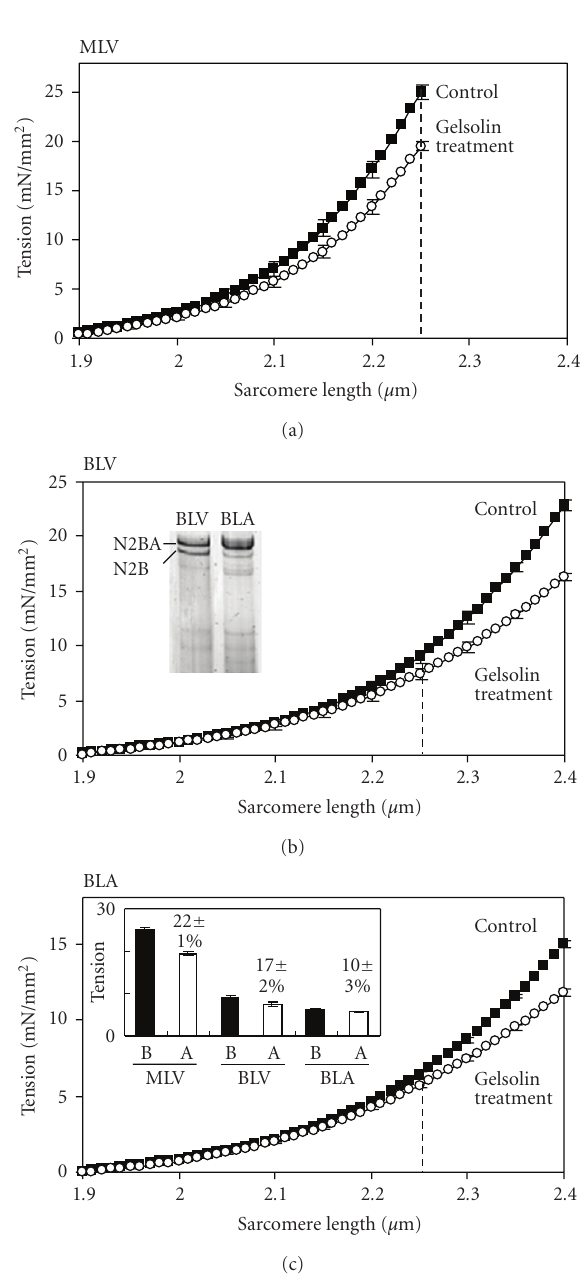
Figure 1: Measurements of total passive tension, before and after gelsolin treatment. (a) mouse left ventricle (MLV), (b) bovine left ventricle (BLV), (c) bovine left atrium (BLA) before gelsolin extraction (control, black) and after gelsolin treatment (white). Gelsolin treatment decreases passive tension. Inset of (b): example of titin gel (SDS agarose) with BLV and BLA samples. Inset of (c): tension at SL = 2.25 μ m before and after gelsolin treatment with % tension reduction. MLV is more greatly a ff ected by thin filament extraction than BLA, with BLV at an intermediate level. Error bars are SE (for clarity plotted only every 0.05 μ